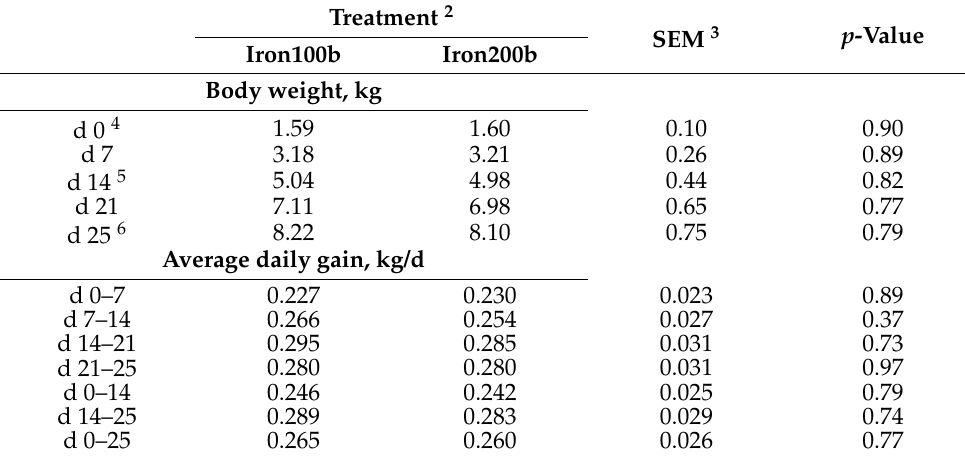
Table 3. Preweaning growth performance of pigs injected with different levels of iron at birth and additional iron before weaning in Experiment 2 1 .